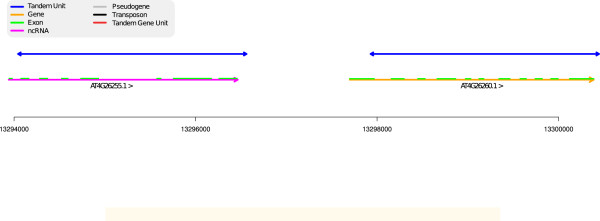
A protein coding gene and a lncRNA. Region 13,294,000-13,300,500 of chromosome 4. The two TUs of this TA respectively cover a lncRNA and a protein coding gene suggesting a possible protein-coding gene origin for the lncRNA.